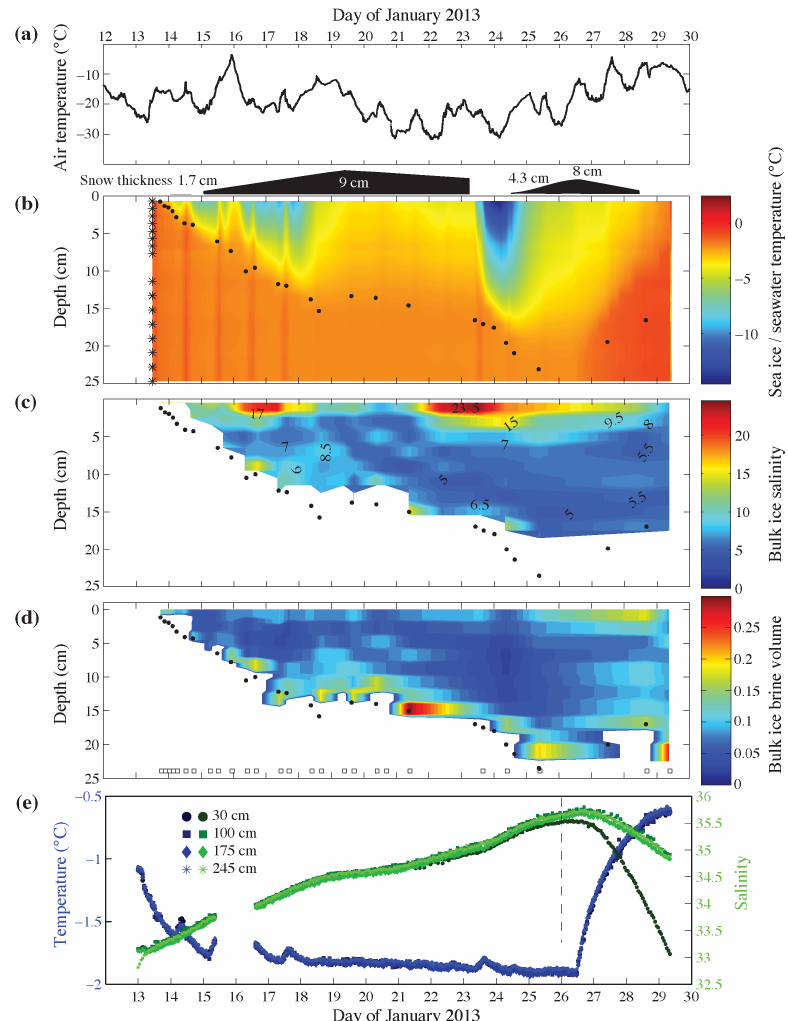
Figure 2. Evolution of (a) air temperature ( ◦ C) at 2m height, (b) snow thickness (black shaded areas) and sea ice/seawater temperature ( ◦ C), (c) bulk ice salinity, (d) brine volume content within sea ice and (e) seawater temperature (blue) and salinity (green). Measurements were performed at 30, 100, 175 and 245cm water depths. The darker the color is, the closer to the surface. In panels (b–d) sea ice thickness is illustrated by black dots. Stars on panel (b) represent the depth at which the temperature profiles are derived from. Open squares in the lower part of (d) mark the sampling times. The dashed line on panel (e) indicates when the heat at the bottom of the pool was turned back